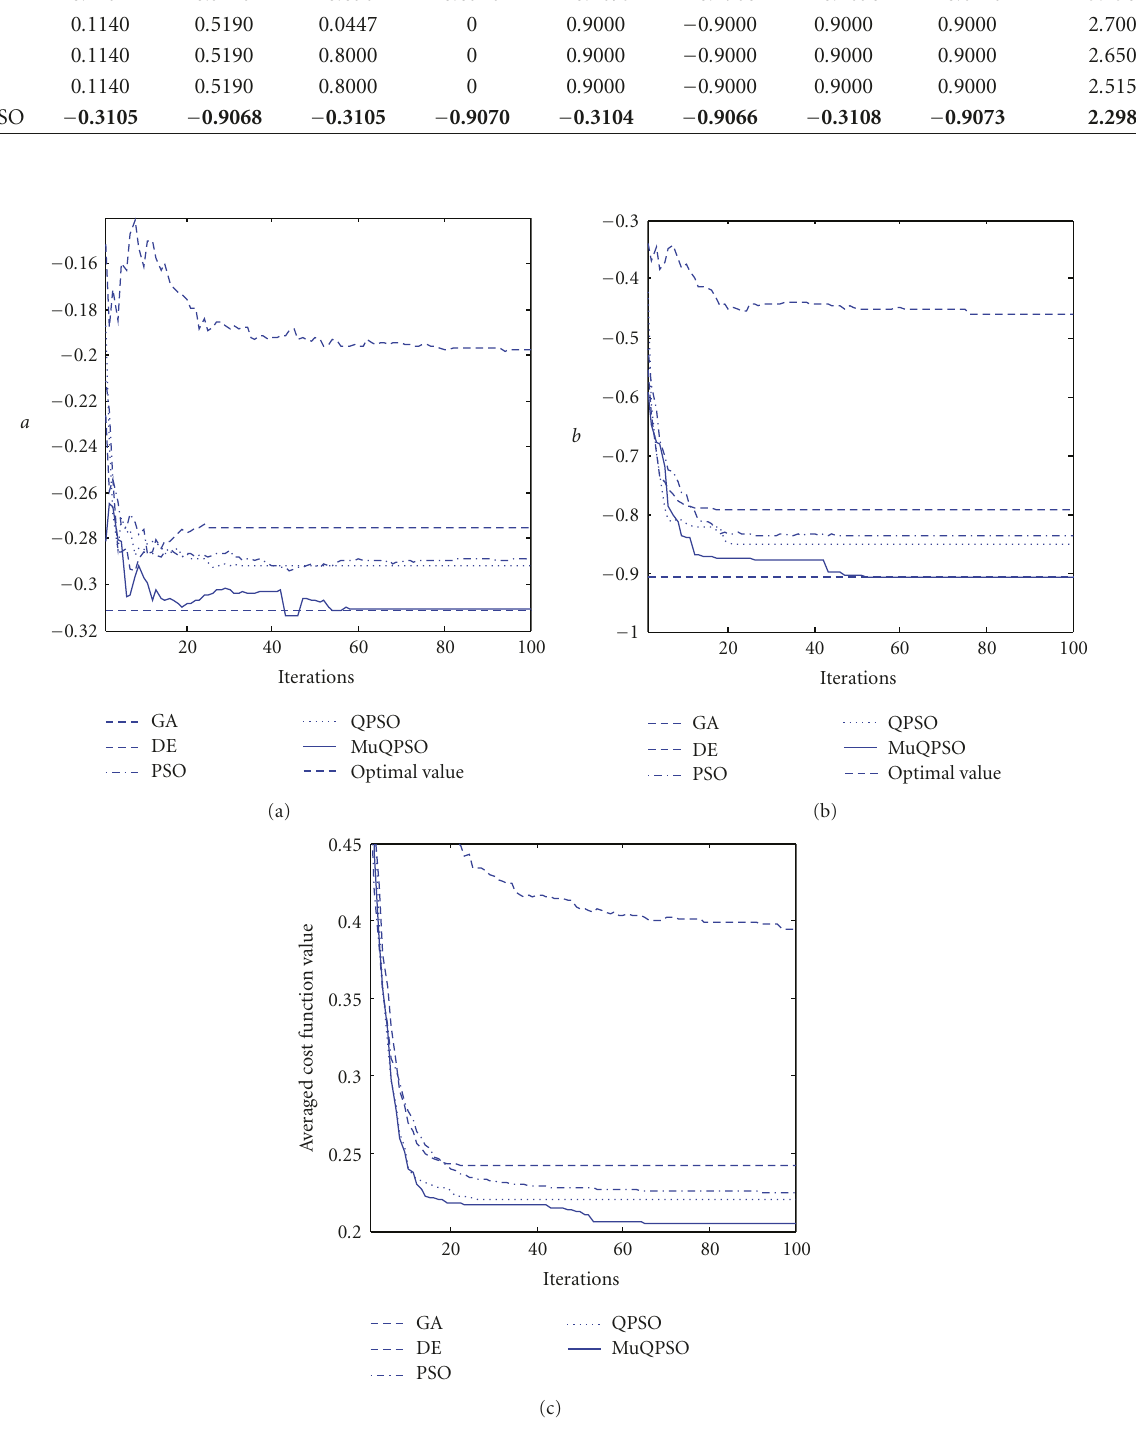
Figure 1: Coe ffi cients a (a) and b (b) learning curves for Example 1 and comparison of convergence behaviours for Example 1